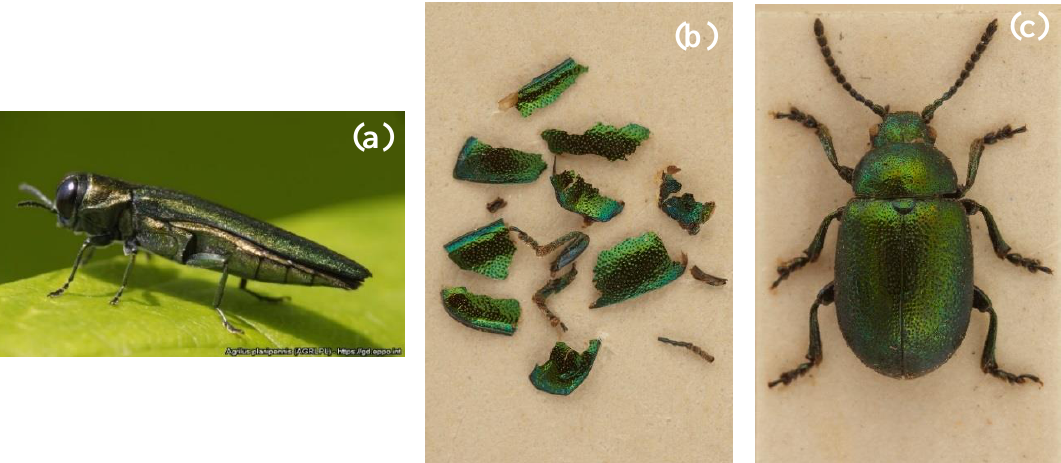
Figure 7. Fragments suspected to be emerald ash borer but actually green dock beetle. ( a ) Emerald ash borer (Courtesy: Eduard Jendek); ( b ) suspect emerald ash borer (UK Crown Copyright, Courtesy of Fera); ( c ) green dock beetle (UK Crown Copyright, Courtesy of Fera).